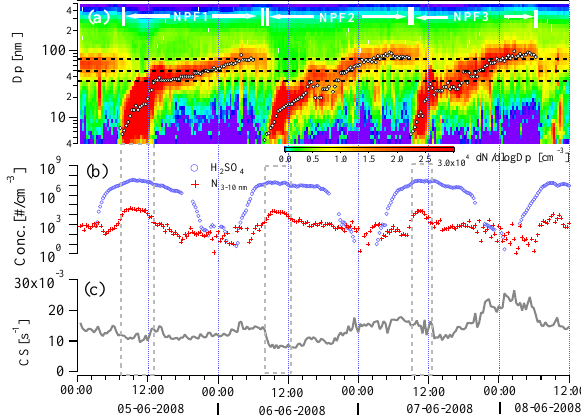
Figure 1. Particle number size distribution (a) , 3–10nm particle number concentration and H 2 SO 4 concentration (b) , and conden- sation sink (CS) (c) during the NPF events. The starting and ending times of the events are marked at the top of panel (a) by NPF1, NPF2, and NPF3. The black circles in the panel (a) are the D m of new particles modes. The grey dashed lines indicated the time period of particle formation. The black dashed lines in panel (a) in- dicate the particle sizes of 35, 50, and 75nm. In the panel (b) , the particle number concentration and H 2 SO 4 concentration share the same y axis and the unit.